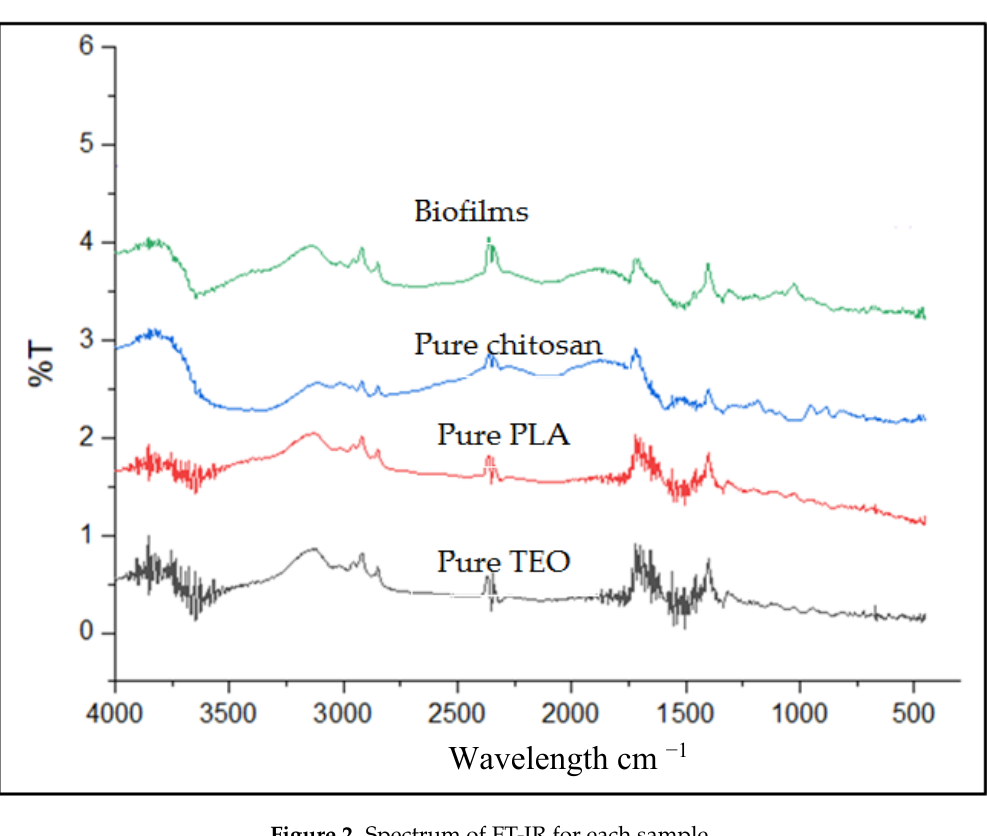
Figure 2. Spectrum of FT-IR for each sample.